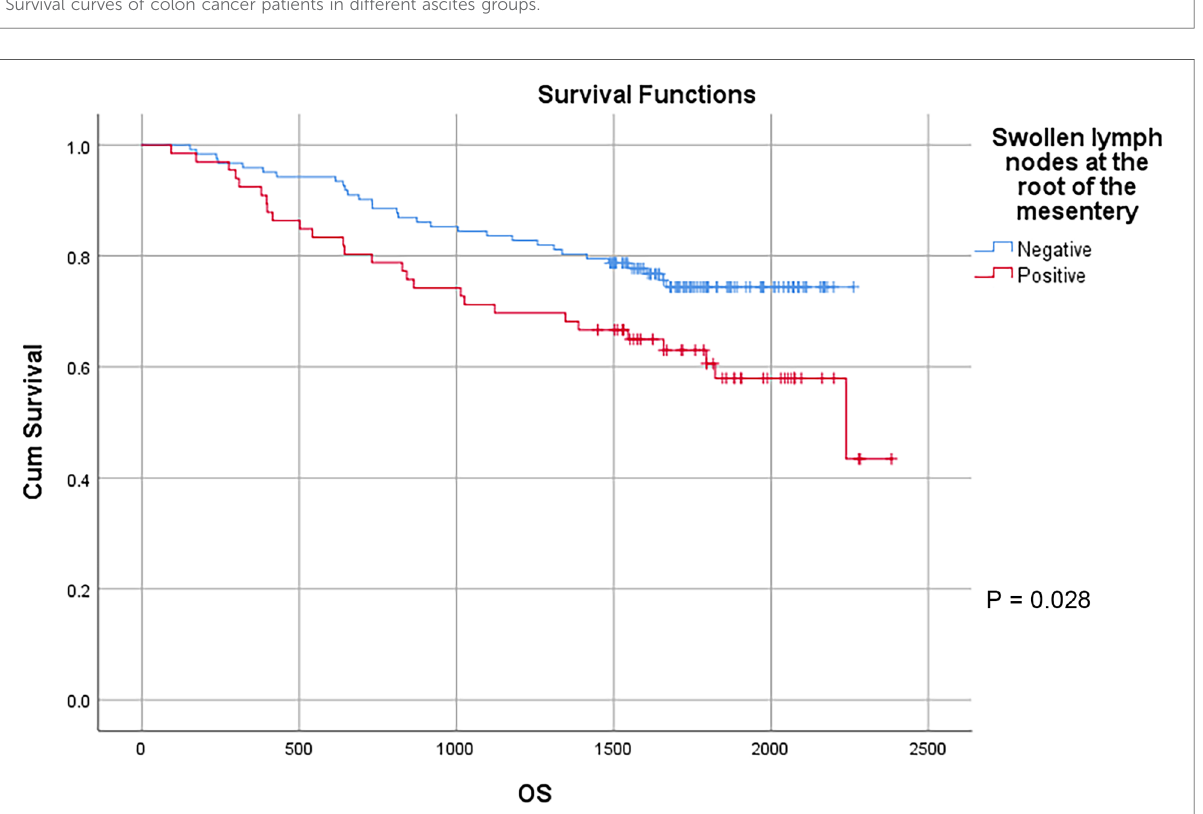
FIGURE 3 Survival curves of colon cancer patients in different swollen lymph nodes at the root of the mesentery